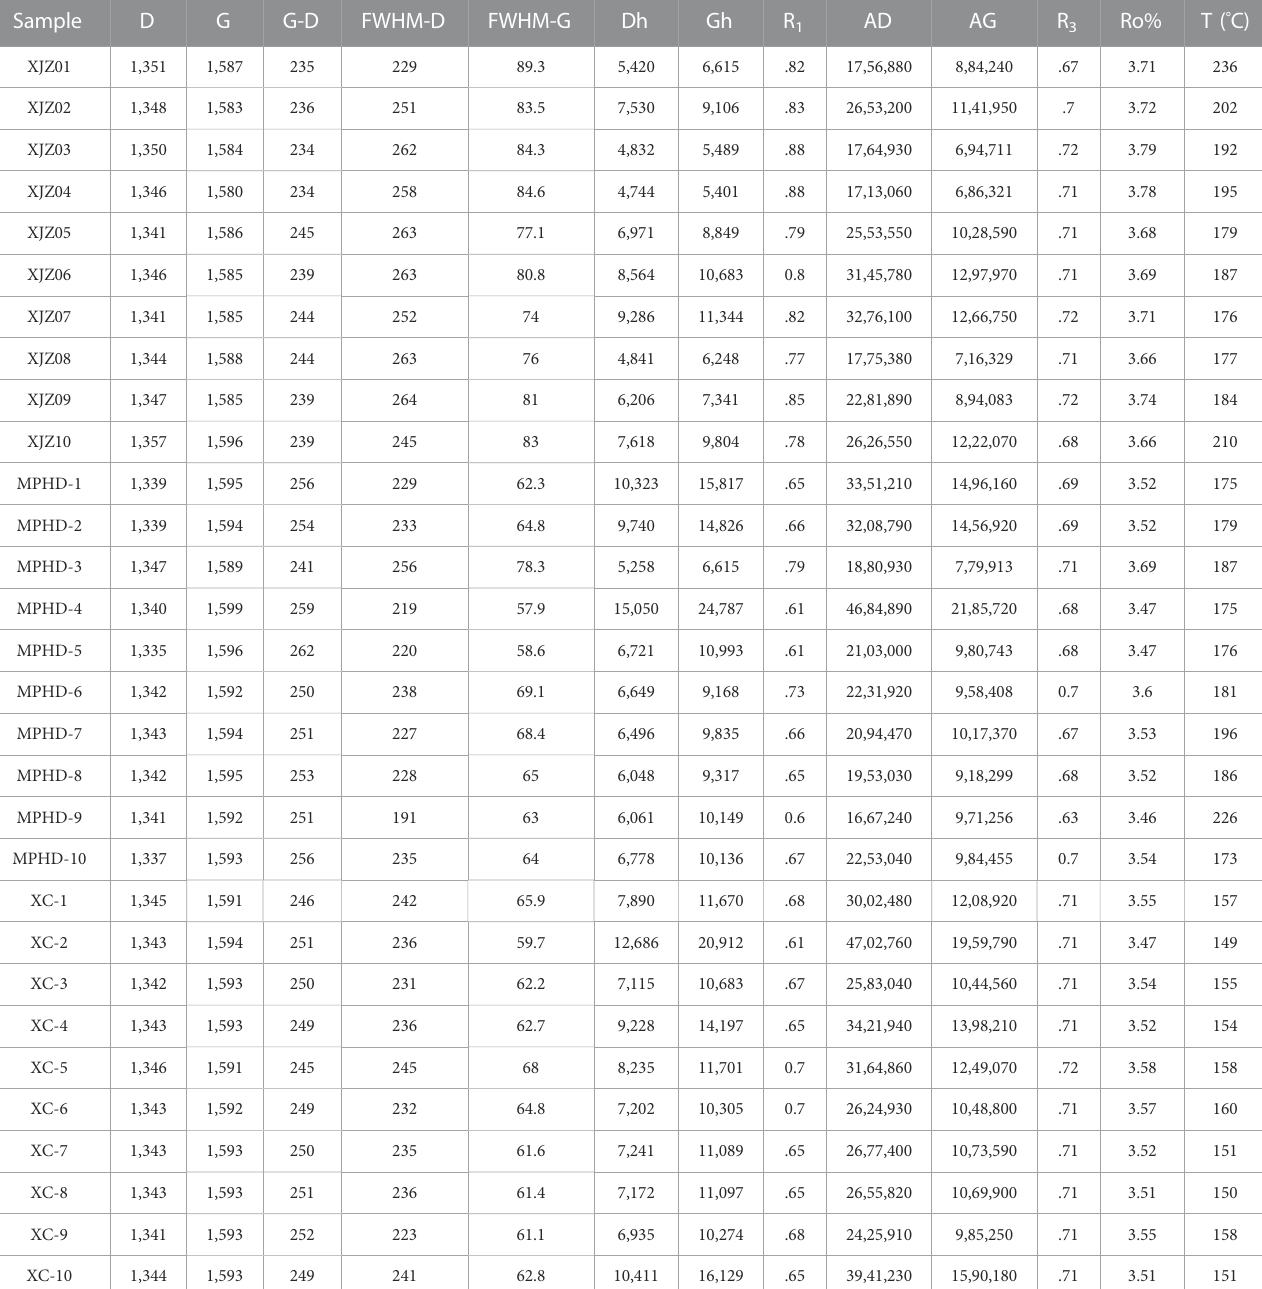
TABLE 1 Relevant parameters of the Raman spectra of bitumen for estimated temperatures and estimated organic maturity.